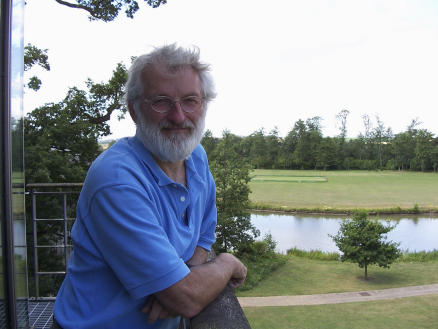
Sir John Sulston